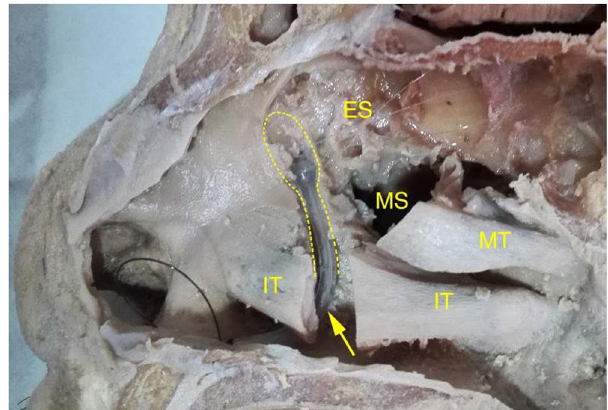
Figure 1. Pre-experiment RSHSI was initially performed on cadavers. The yellow dashed line represents the lacrimal sac and nasolacrymal duct. The yellow arrow represents the Spherical Headed Silicone Tube. IT, inferior turbinate; MT, middle turbinate; M, maxillary sinus; ES, ethmoid sinus.